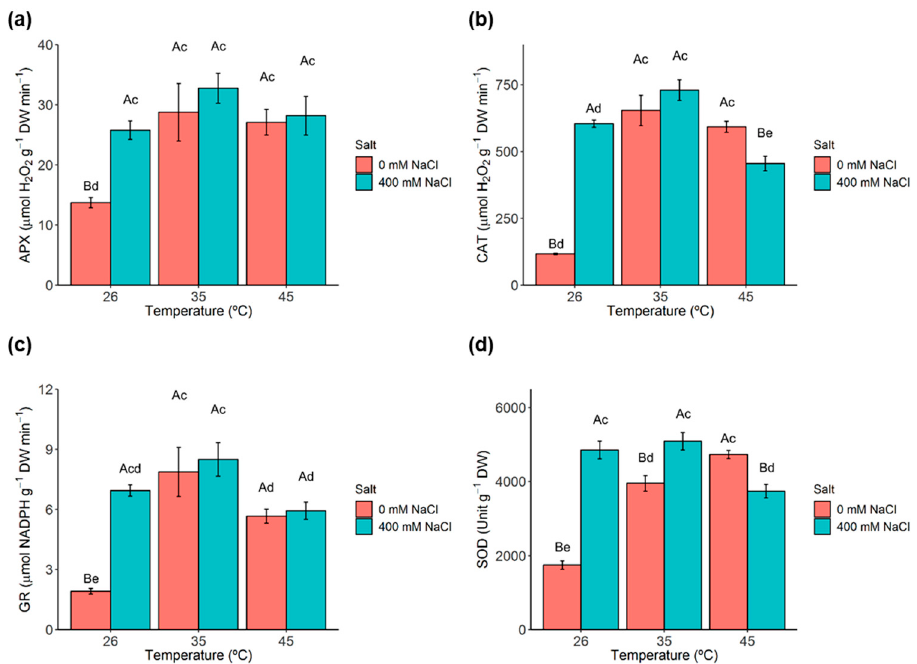
Figure 5. Evaluation of antioxidant enzyme activities in C. glauca branchlets under the single and combined exposure to salt (0 and 400 mM NaCl) and temperature (26, 35 and 45 ◦ C) conditions. ( a ) ascorbate peroxidase (APX). ( b ) cellular catalase (CAT). ( c ) glutathione reductase (GR). ( d ) su- peroxide dismutase (SOD). Bars represent the mean values ± SE from three to five independent measurements. Two-way ANOVA ( p < 0.05) followed by Tukey’s HSD test was for performed for means comparison and different letters express significant differences between [NaCl] for the same temperature (A, B) or between temperature for the same [NaCl] (c, d, e) with A and c representing the highest